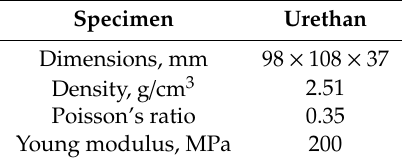
Figure 1. ( a ) Rubber-wheel dimensions, ( b ) Transparent road surface replica (pavement), ( c ) Experimental setup of ultraviolet-induced fluorescence. Table 1. Specification of road surface replica.